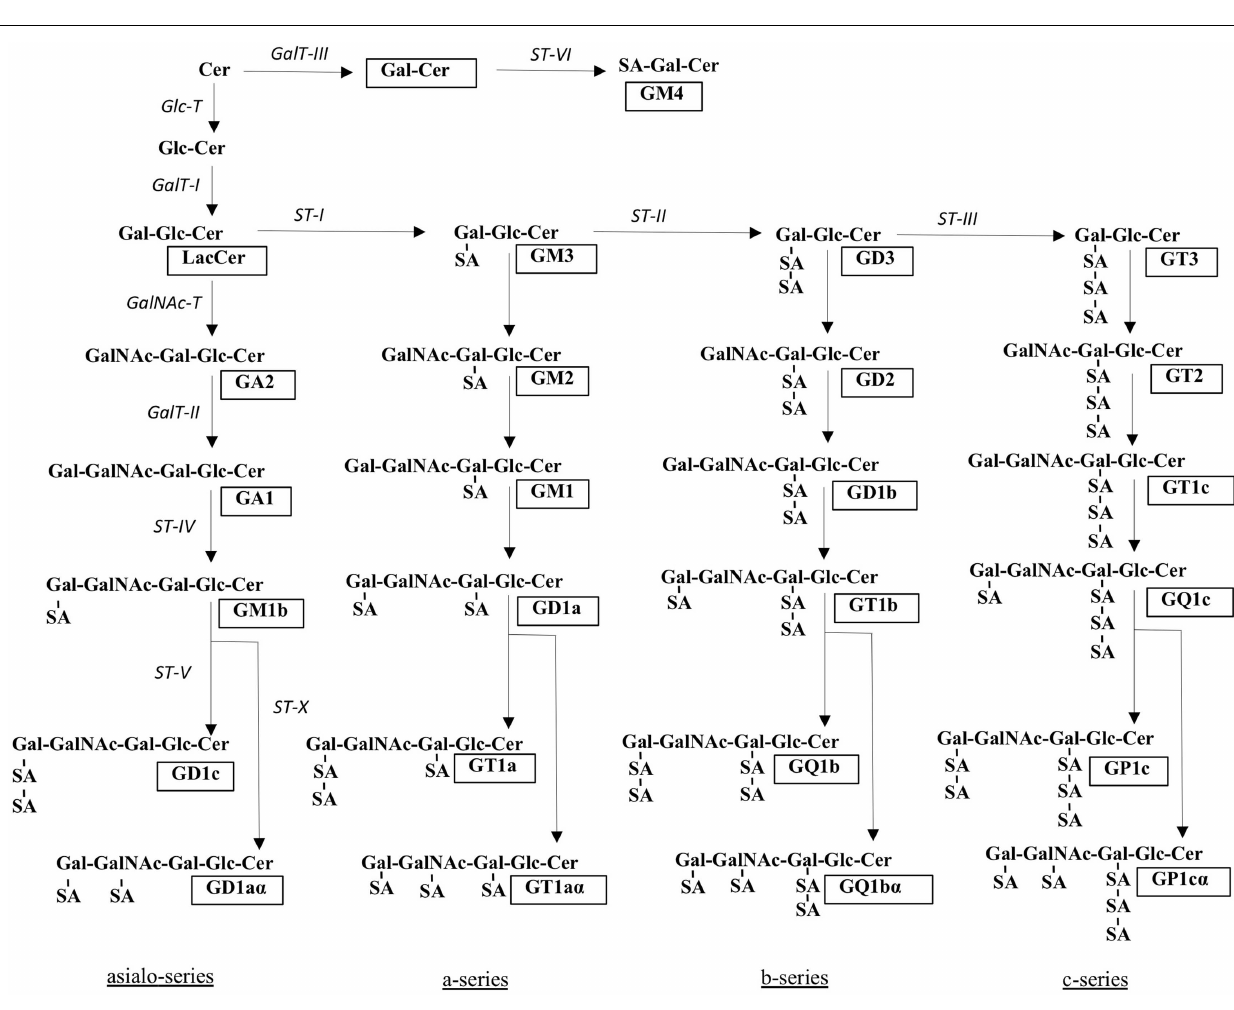
little is known about how glycosyltransferases are regulated